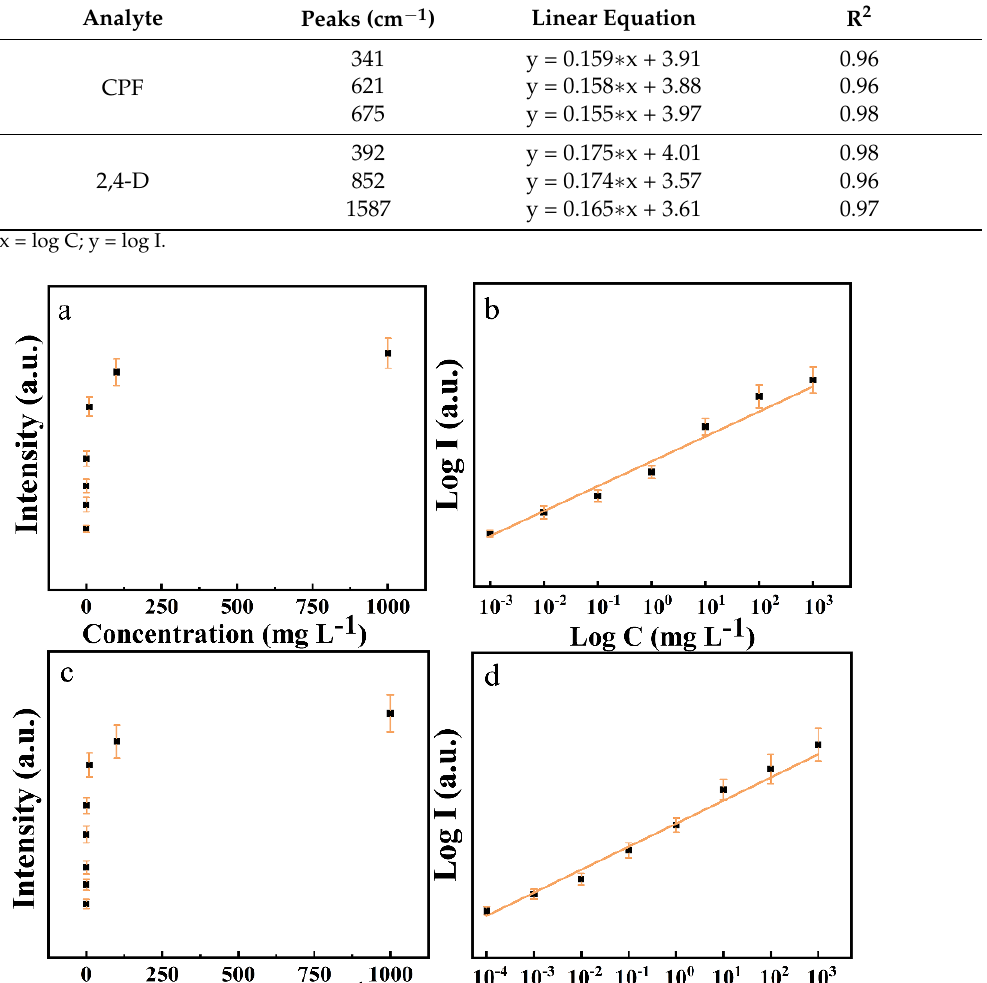
Table 4. Recovery results of CPF and 2.4 − D on apple surface sample.